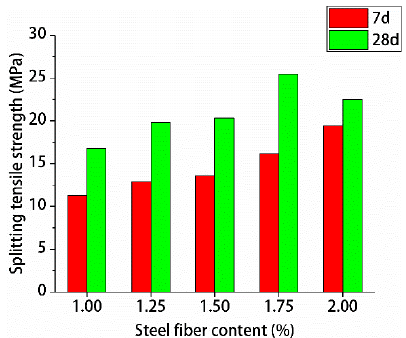
Figure 13. Test results for compressive strength.